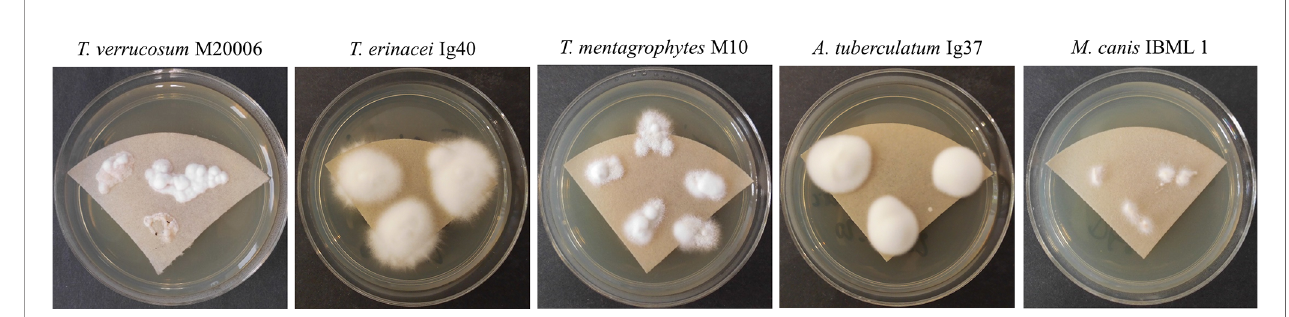
FIGURE 3 | Sabouraud-Dextrose agar (2%) covered with a sterilized fi lter paper promoted fungal growth successfully and facilitated sampling of merely fungal material for MALDI-TOF MS analysis. Different Trichophyton (T.), Arthroderma (A.) and Microsporum (M.) isolates are exemplarily shown after an incubation time of 5d at 28°C ( T. verrucosum: 37°C). Species identity was con fi rmed by sequencing of the ITS region of fungal